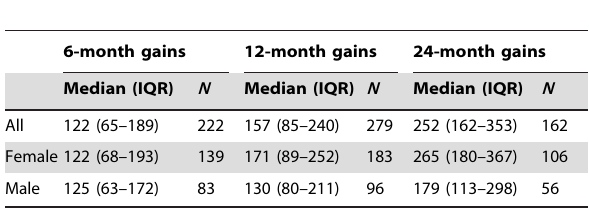
Table 4. Median CD4 T-cell count (cells/ m L) gains during ART stratified by